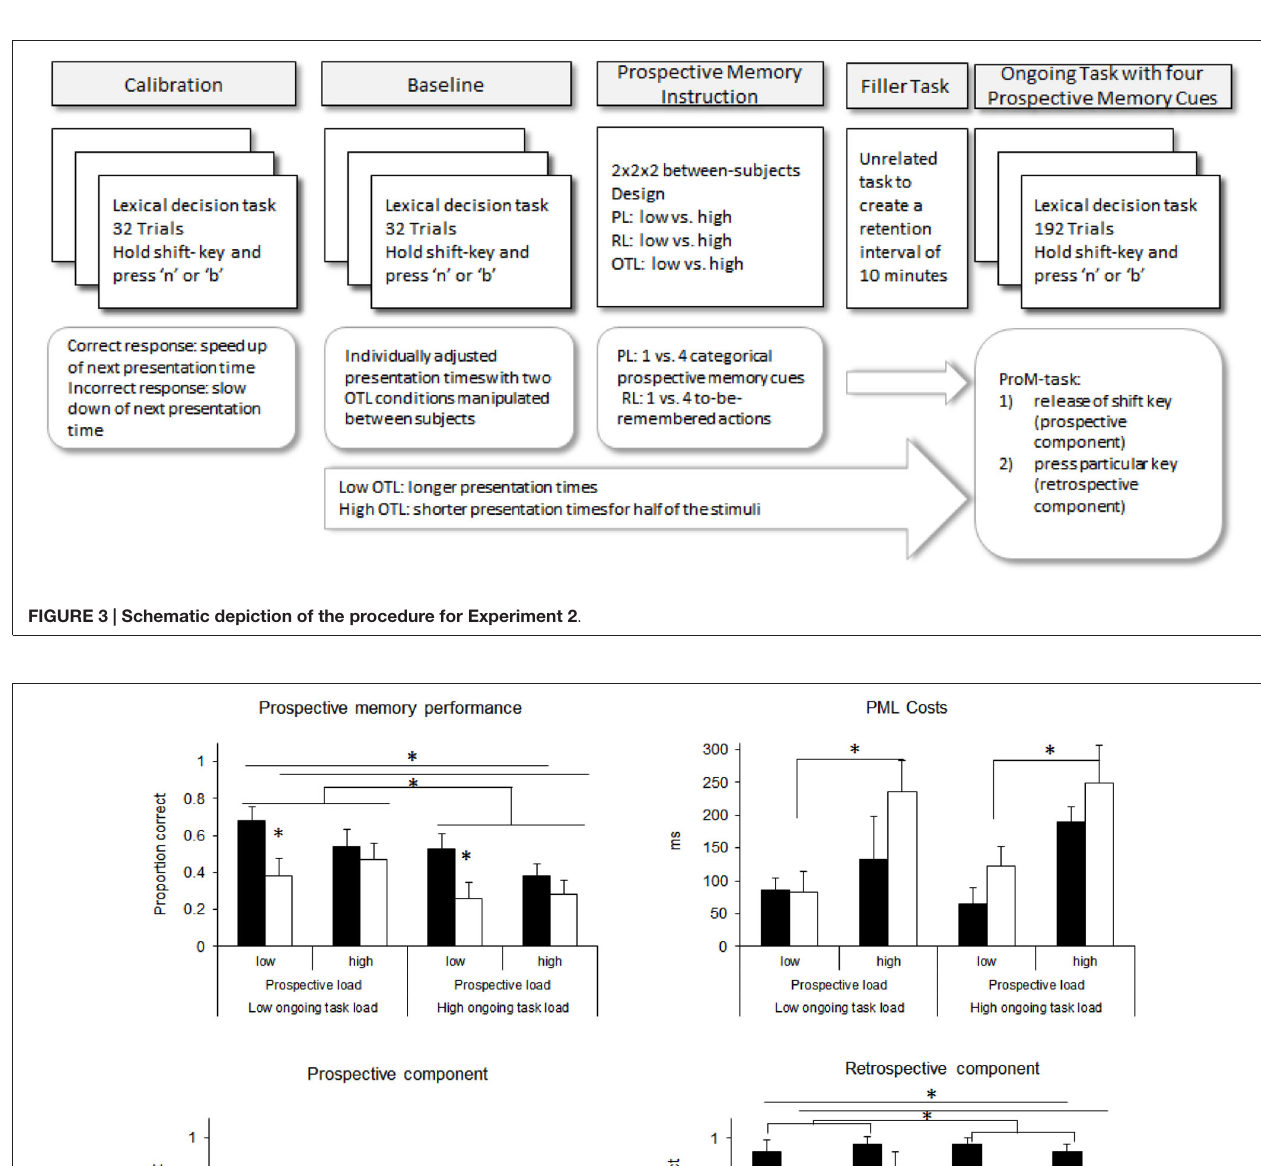
(pressing the correct response) . Black bars represent the low RL condition, white bars the high RL conditions. Significant differences ( p < 0.05) are indicated by asterisks. Error bars represent standard